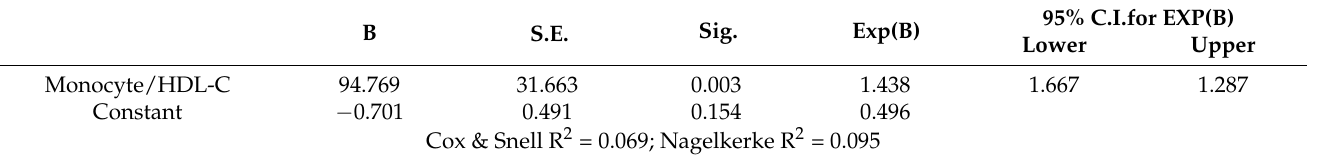
Table 4. Logistic Regression Analysis of the Effect of Monocyte/HDL-C on Schizophrenia.